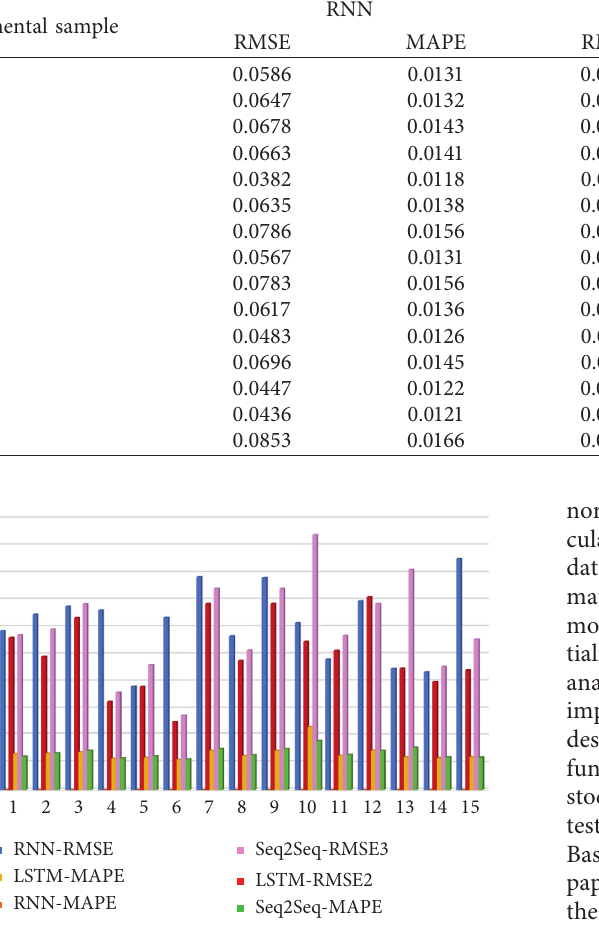
Figure 10: Comparison of prediction results of network